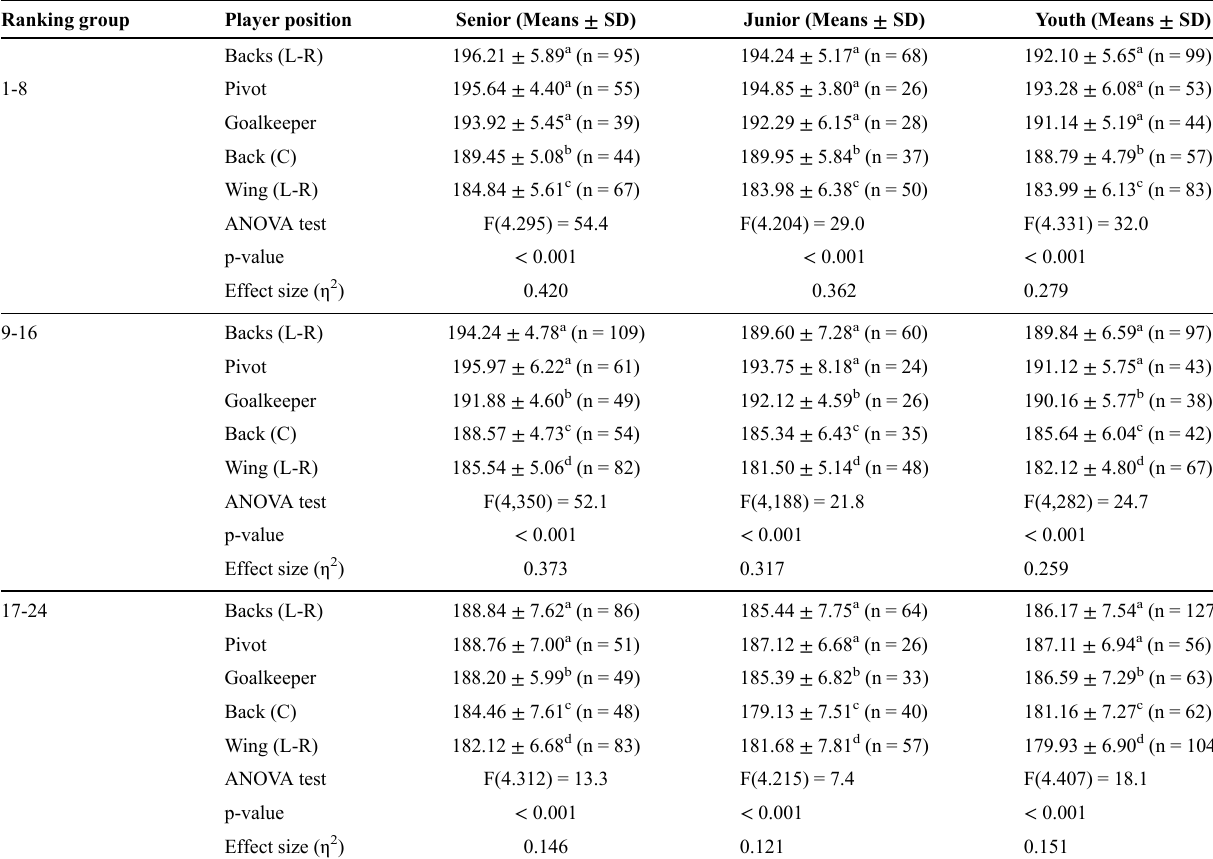
Table 4 - Descriptive statistics of height (Mean ± SD) in cm per player position in each age category and ranking group. Between positions ANOVA separately for each age category and ranking group. Ranking group